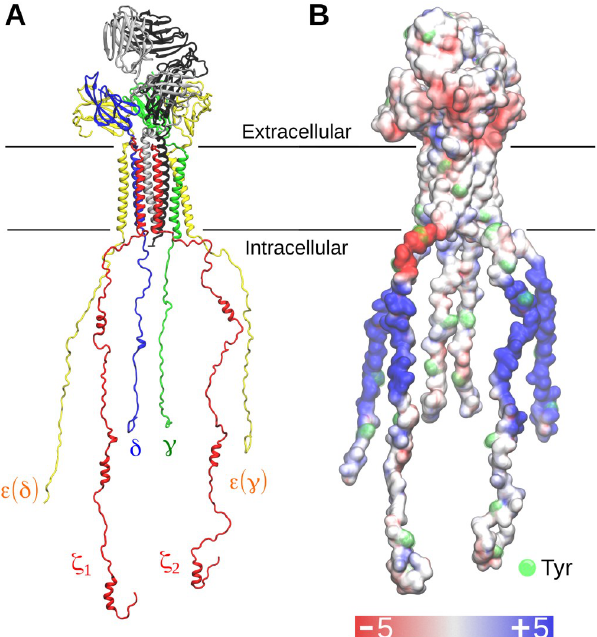
Fig 1. The T cell receptor structure. (A) Model of the entire T cell receptor used in our simulations. (B) Electrostatic profile of the TCR-CD3. A range of ± 5 kT/e was used to indicate the electronegative and electropositive regions as shown in red and blue respectively. The calculation of the electrostatic profile was done using the APBS tool [18].